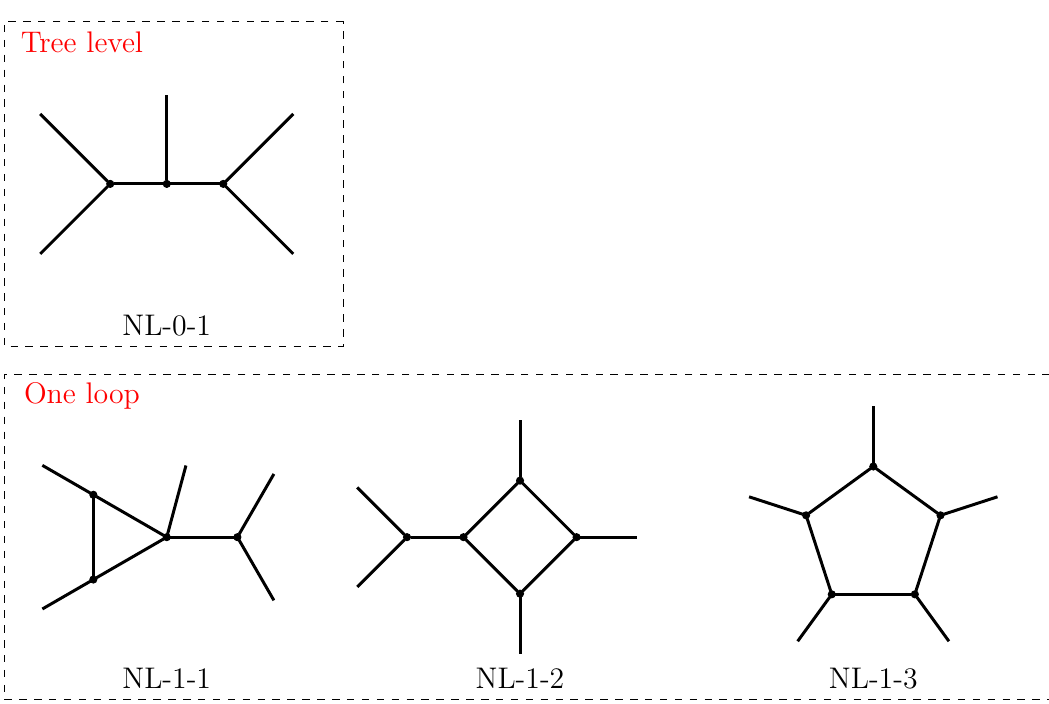
Figure 2 . The tree-level and one-loop topologies that can lead to genuine models of long-range 0 νββ decays.